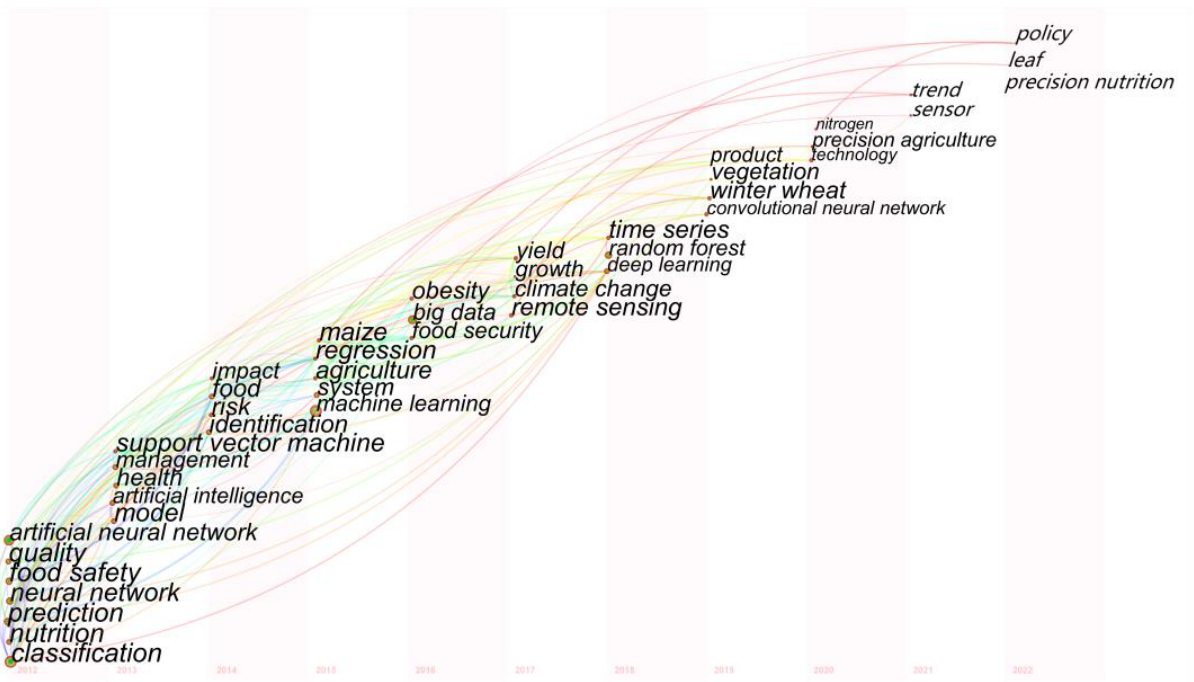
Figure 12. The keyword time zones of AI-related publications in 2012 – 2022.